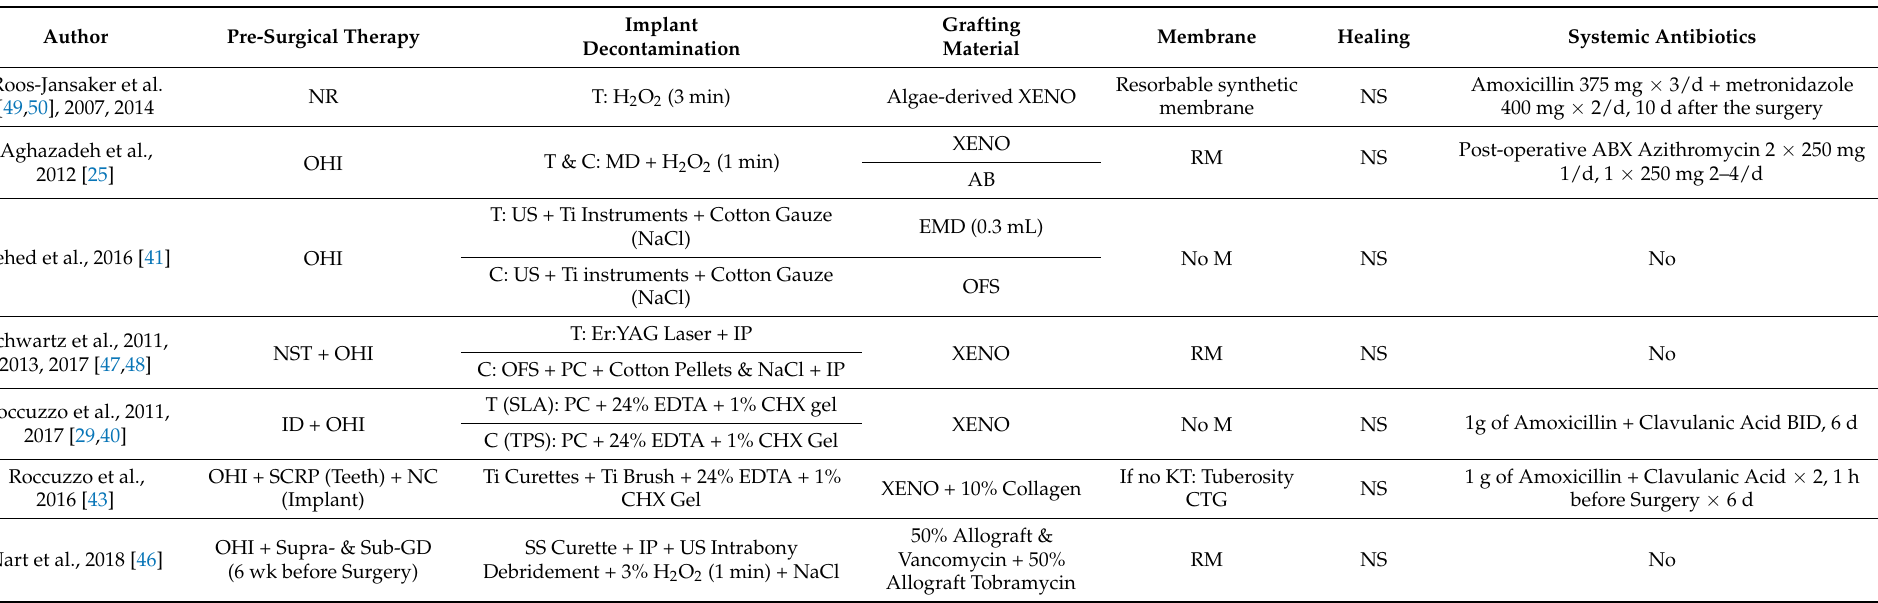
Table 1. Implant surface decontamination and regenerative techniques material employed by the reported human studies. The kind of surgical healing (submerged and non-submerged) was reported as well as the antibiotic therapy prescribed to research subjects. OHI (Oral Hygiene Instructions); NST (Non-surgical Therapy); ID (Implant Debridement); NC (Neck Cleaning); GD (Gingival Debridement); d (Day); wk (Week), m (month); MD (Mechanical Debridement); IP (Implantoplasty); Ti (Titanium); SCRP (Scaling and Root Planing); OFS (Open Flap Surgery); PC (Plastic Currette); AB (Autogenous Bone); M (Membrane); RM (Resorbable membrane); NR (Non-resorbable Membrane); ABX (Antibiotic); NS (Non-Submerged), XENO (Xenograft), EMD (Emdogain); CHX (Clorhexidine); T (Test); C (Control); CTG (Connective Tissue Graft); BID (Twice a Day); SS (Stainless Steel); US (Ultra Sonic); EDTA (Ethylenediaminetetraacetic Acid). Adapted from Ramanauskaite et al.